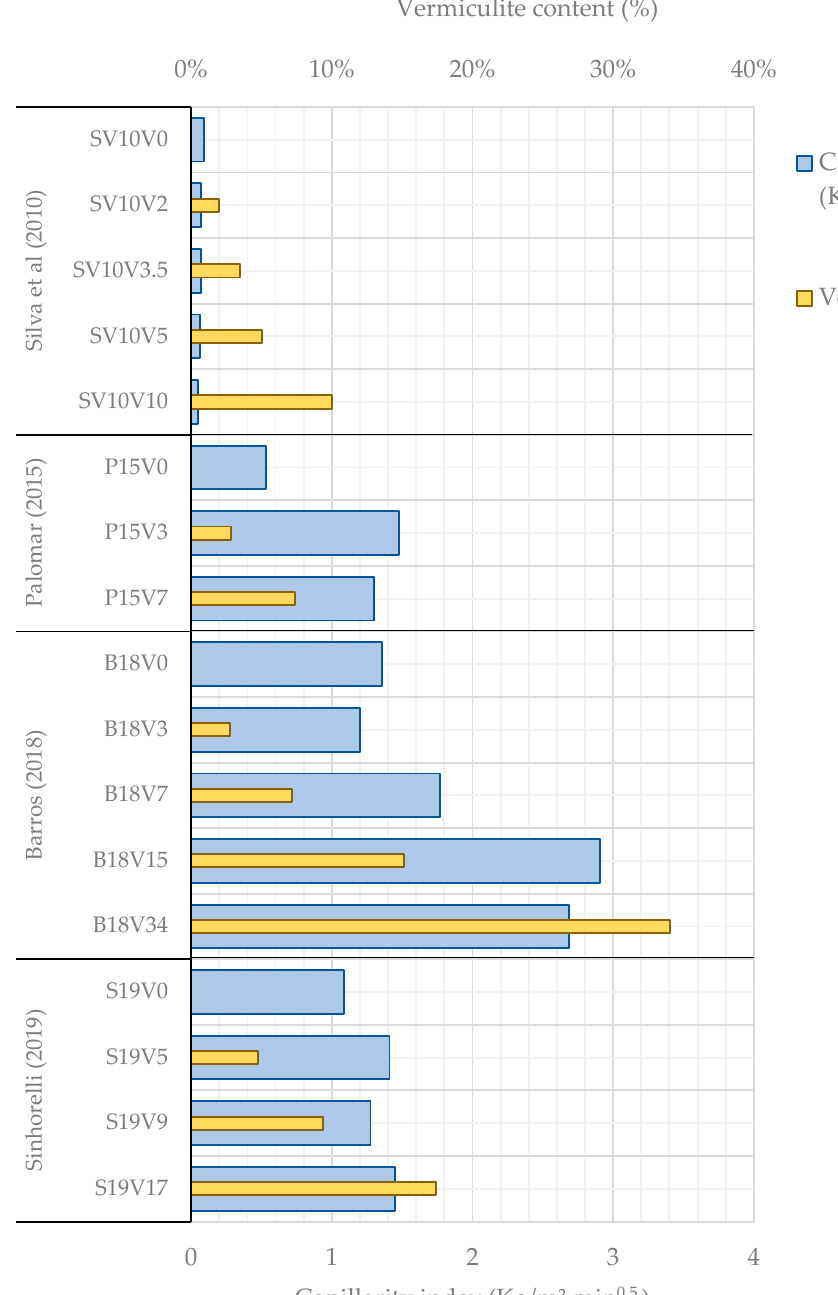
Figure 8. Correlation of the values of capillarity index and vermiculite content of the studied articles [17,41,44,45].